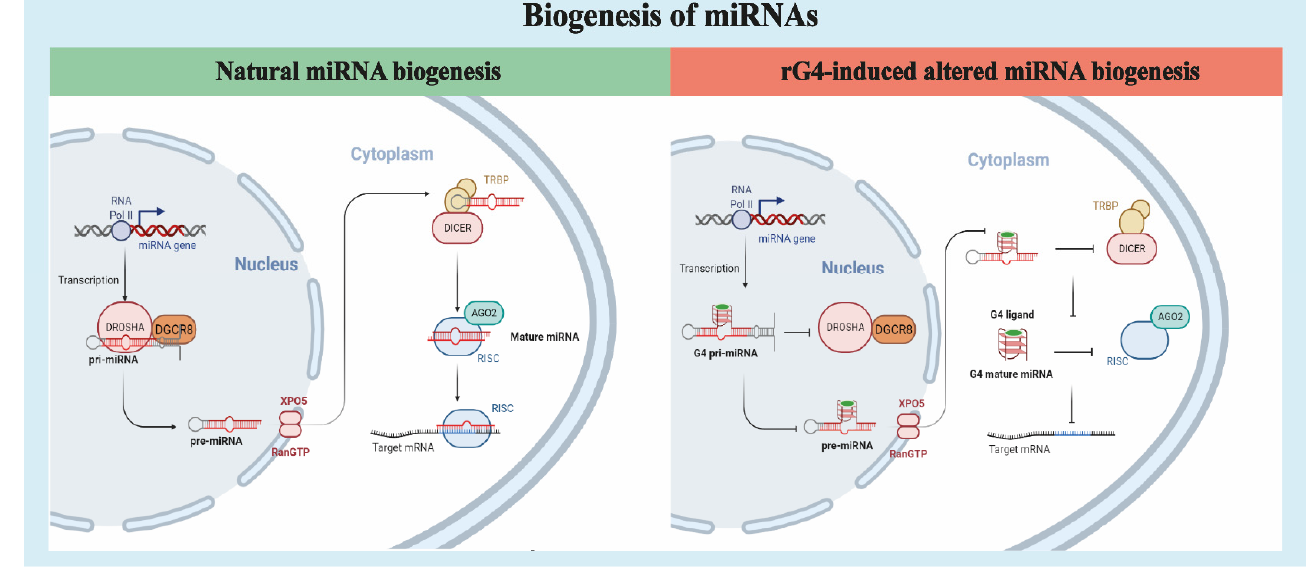
Figure 8. Biogenesis of miRNAs. Comparison of natural biogenesis versus interference of the rG4s in the biogenesis and function of miRNAs.